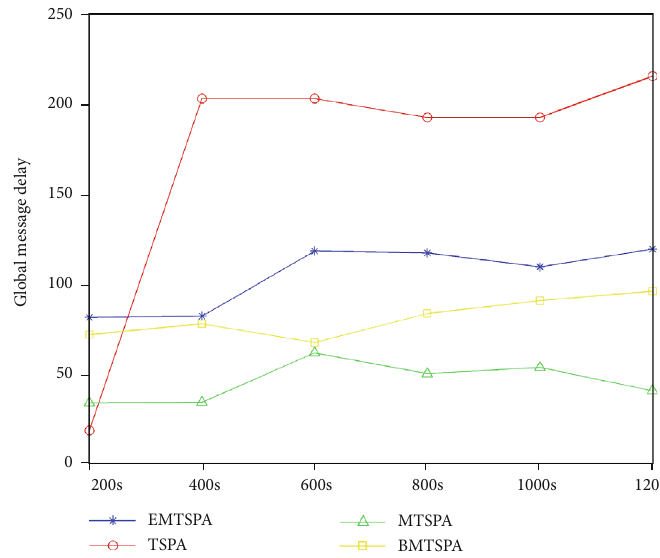
Figure 13: Results of